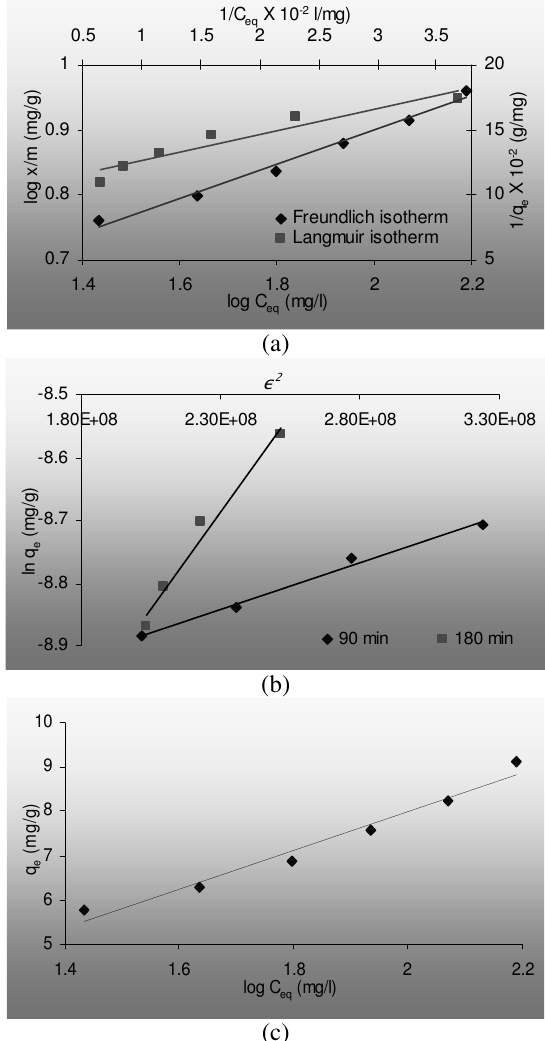
Figure 8. (a) Freundlich and Langmuir, (b) DKR, and (c) Temkin isotherm for sorption of Cu +2 on